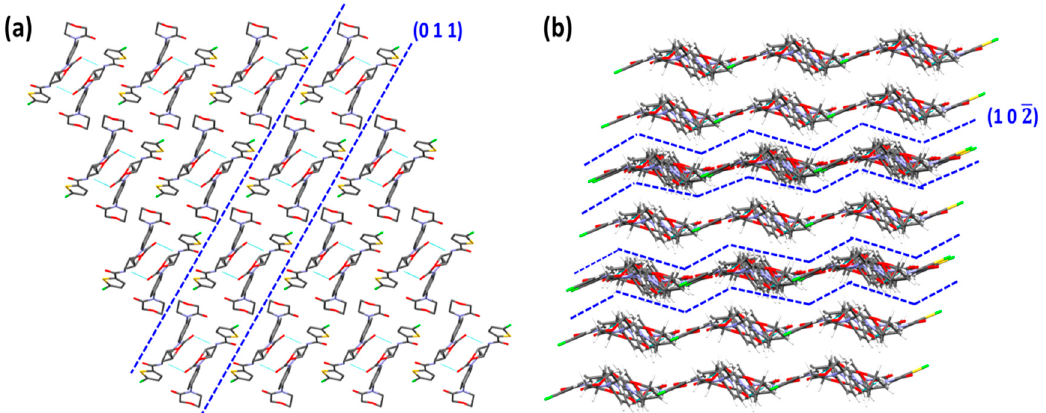
Figure 9. Crystal structure evaluation of RIV indicating the presence flat layers of RIV molecules with 1D hydrogen bonding along (0 1 1) plane ( a ), and corrugated layers along (1 0 2(cid:3364) ) plane ( b ).